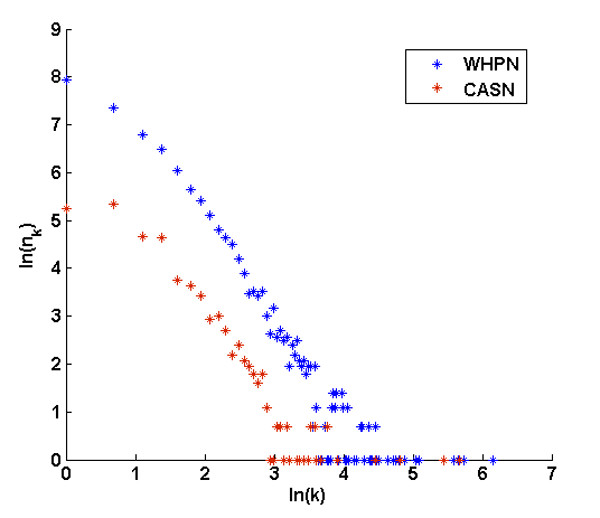
The degree distributions of WHPN and CASN. The degree distributions of WHPN (blue star) and CASN (red star) are shown. K is the degree of the nodes and the x axis is the ln transformed degree ln(k). The y axis is the ln transformed number of nodes for which the degree is k, ln(nk).